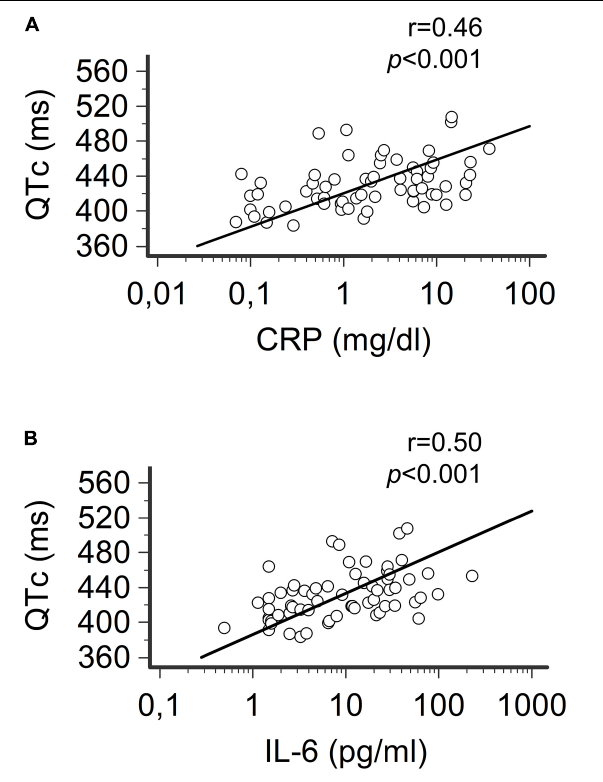
FIGURE 2 | Correlation between QTc, CRP, and IL-6 in patients with COVID-19 over time. (A) Relationship between heart rate-corrected QT interval based on Bazett’s formula (QTc) and CRP levels. (B) Relationship between QTc and Il-6 levels.Spearman’s rank correlation. Patients, n =